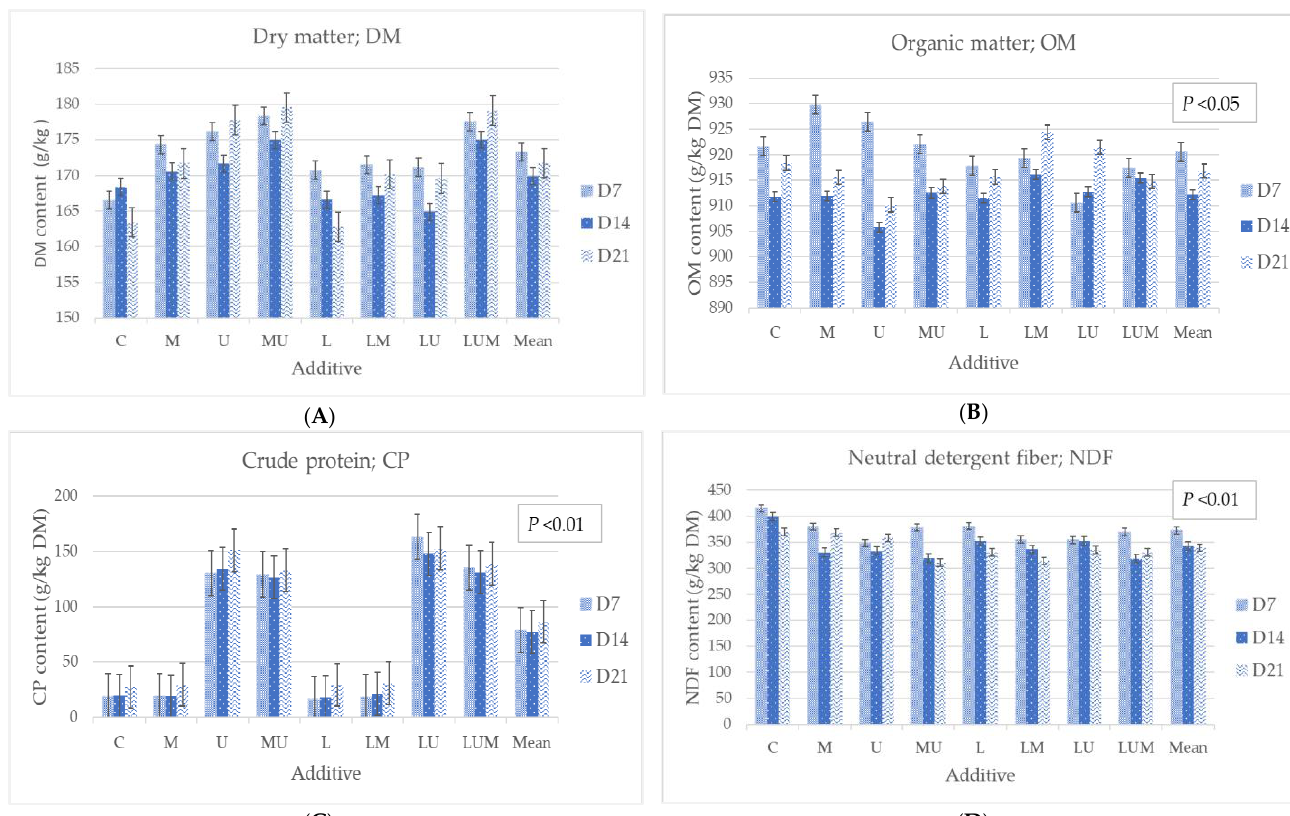
Figure A1. Effect of cassava pulp by treated with Lactobacillus casei TH14, molasses, and urea at different days and the mean of each day of fermentation on ( A ) dry matter; DM, ( B ) organic matter; OM, ( C ) crude protein; CP, ( D ) neutral detergent fiber; NDF, CON = no additive, M= treated with molasses 4% DM, U = treated with urea 4% DM, UM = treated with urea 4% DM and molasses 4% DM, L = treated with LcTH14 105 cfu/kg FM, LM = treated with LcTH14 10 5 cfu/kg FM and molasses 4% DM, LU = treated with LcTH14 10 5 cfu/kg FM and urea 4% DM, and LUM = treated with LcTH14 10 5 cfu/kg FM, urea 4% DM, and molasses 4% DM, DM= dry matter, ammonia-N = ammonia nitrogen, D7 = after 7 days of fermentation, D14 = after 14 days of fermentation, D21 = after 21 days of fermentation, p -value by the effect of the day of fermentation.